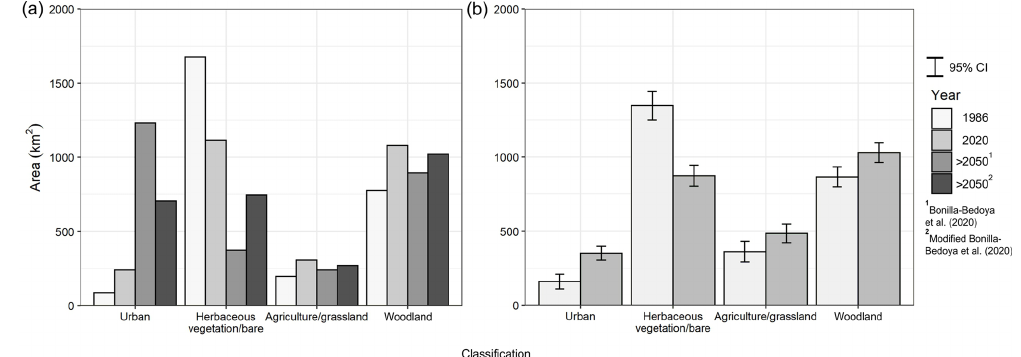
Figure 4. (a) Mapped land cover classification results for 1986 and 2020 alongside modelled future land cover from two scenarios (superscript 1 and 2) using data from Bonilla-Bedoya et al. (2020b). (b) Error-adjusted (e.g. Olofsson et al., 2013, 2014) land cover classification results from 1986 and 2020.